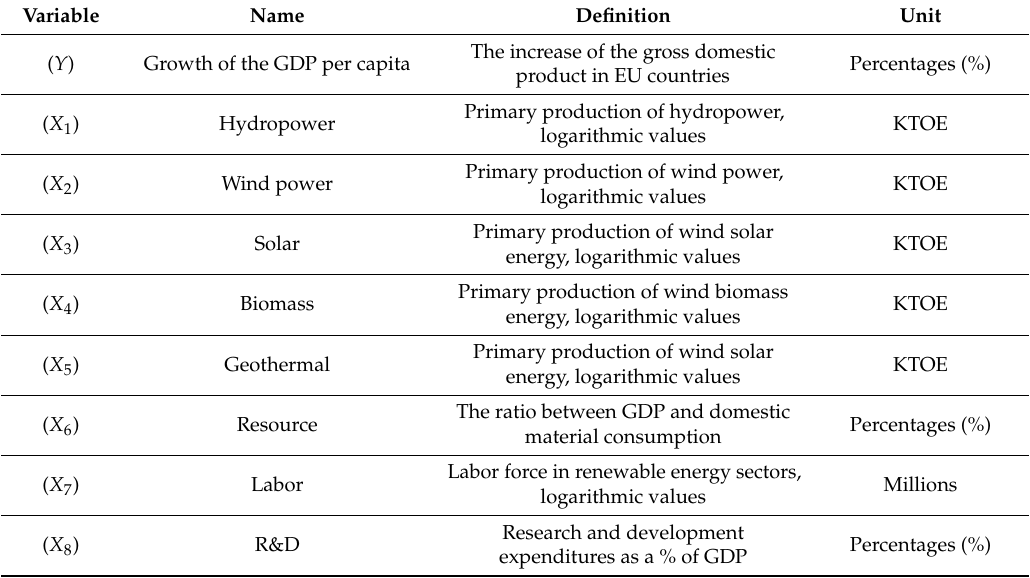
Table 2. Description of the model